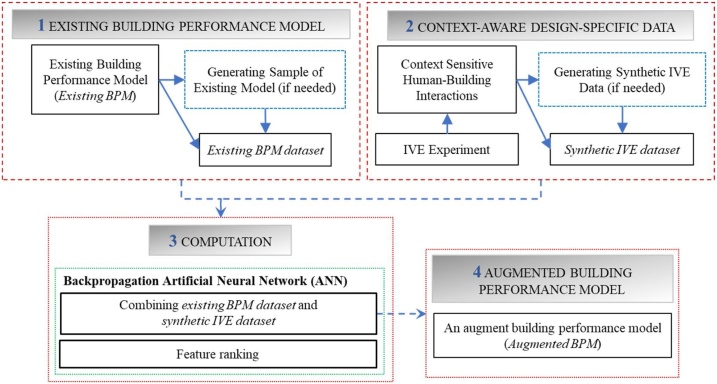
The computational framework [1].